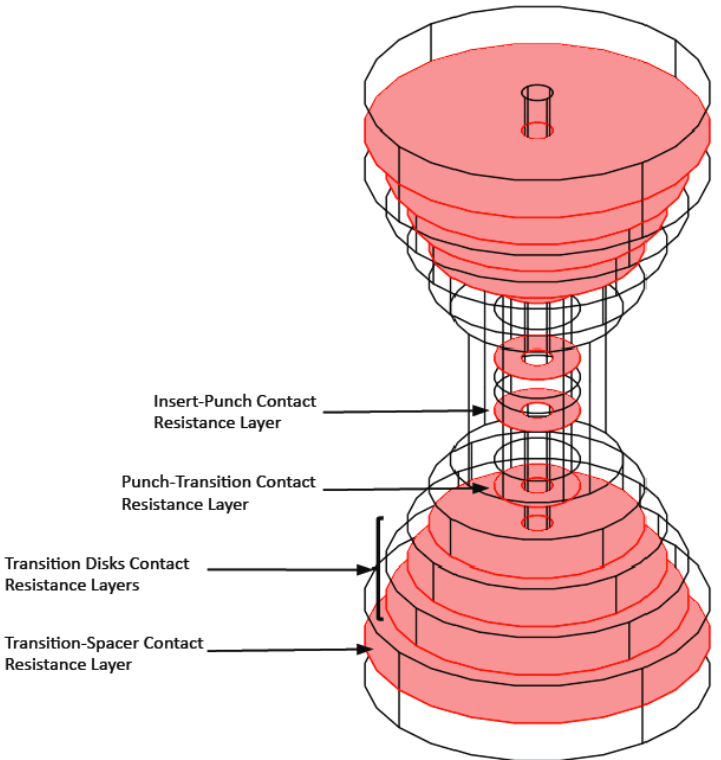
Figure 3. Graphite-graphite horizontal contact resistance layers highlighted for one of the four transitional disks